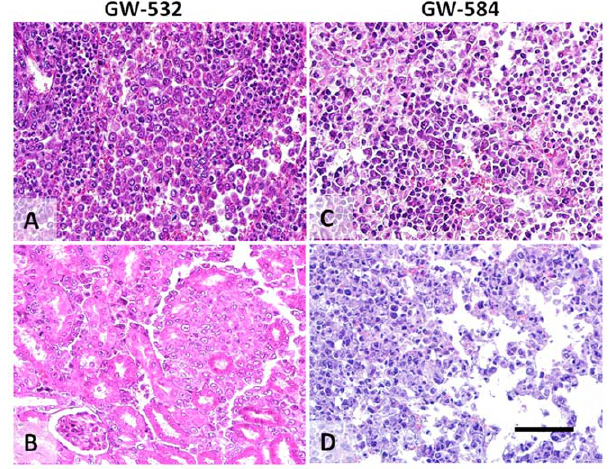
Figure 3. Xenografted tumors were highly aggressive in the hamster, with evidence of widespread metastatic disease. (A) and (B) show metastases in the hamster spleen and kidney, respectively, from a GW-532, generation-2, cheek pouch tumor. (C) and (D) show metastases in the hamster spleen and lung, respectively, from a GW- 584, generation-3, cheek pouch tumor. Metastatic tumors show similar cytological appearance to the cheek pouch xenograft tumors. Scale bar in image D corresponds to 200 m m for all